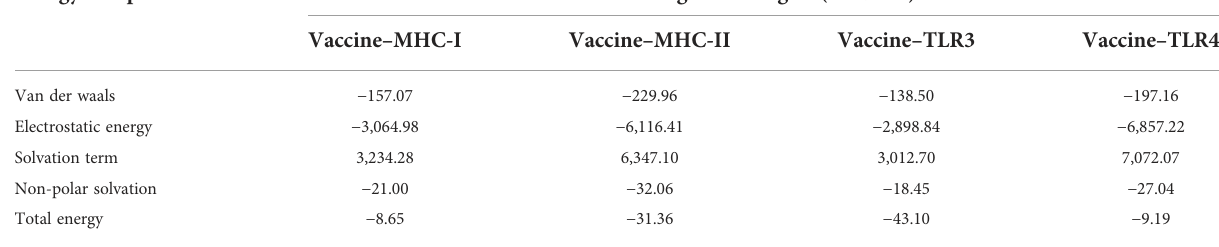
TABLE 9 The binding free energy (kcal/mol) of the vaccine and receptor complex. Energy components Binding free energies (kcal/mol) Vaccine – MHC-I Vaccine – MHC-II Vaccine – TLR3 Vaccine – TLR4